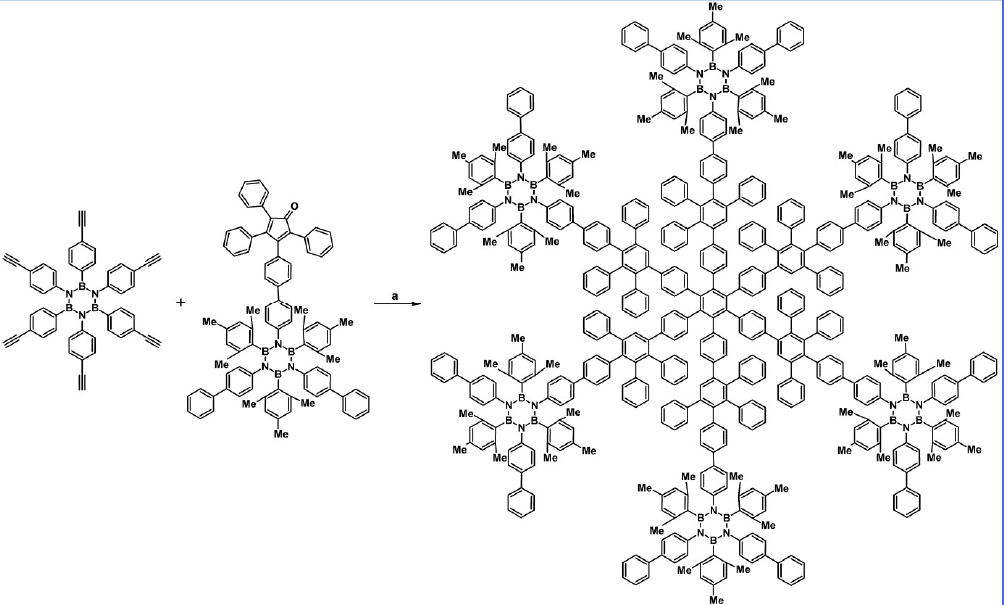
Scheme 205. DA cycloaddition as a crucial step in the synthesis of BN-doped polyphenylene—the second example [255]. Reagents and conditions: a = Ph 2 O, 230 °C, 16 h, Y = 19%. Smith et al. described a series of triarylphosphines that bear large PAH substituents able of engaging in strong π-stacked interactions [256]. HBC-motif was introduced via Diels–Alder cycloaddition–Scholl dehydrocondensation sequences (Scheme 206).